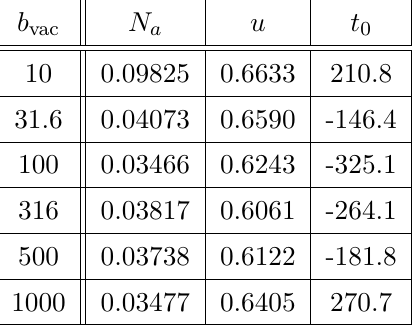
Table 1. The fitted values of N a , u and t 0 in (4.11) for various values of b vac .